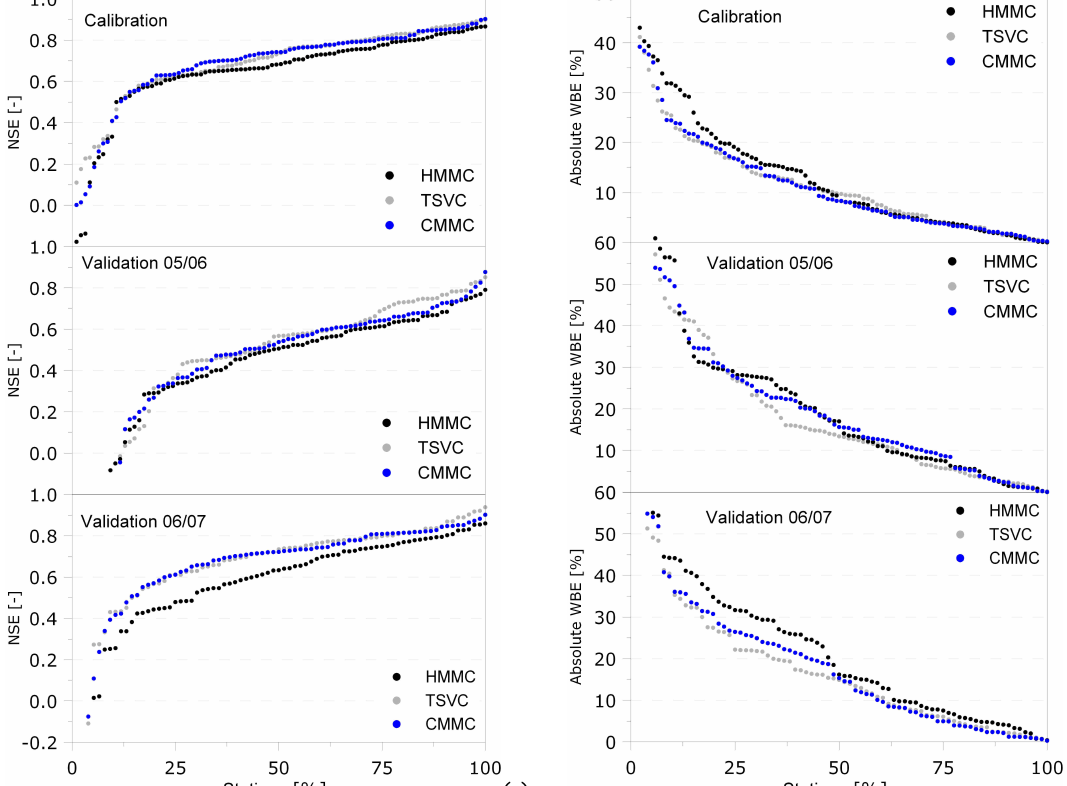
Fig. 19. Calibration and split sample validation results for discharge stations in model domains 1 and 5 including the current mean monthly (CMM) corrected precipitation